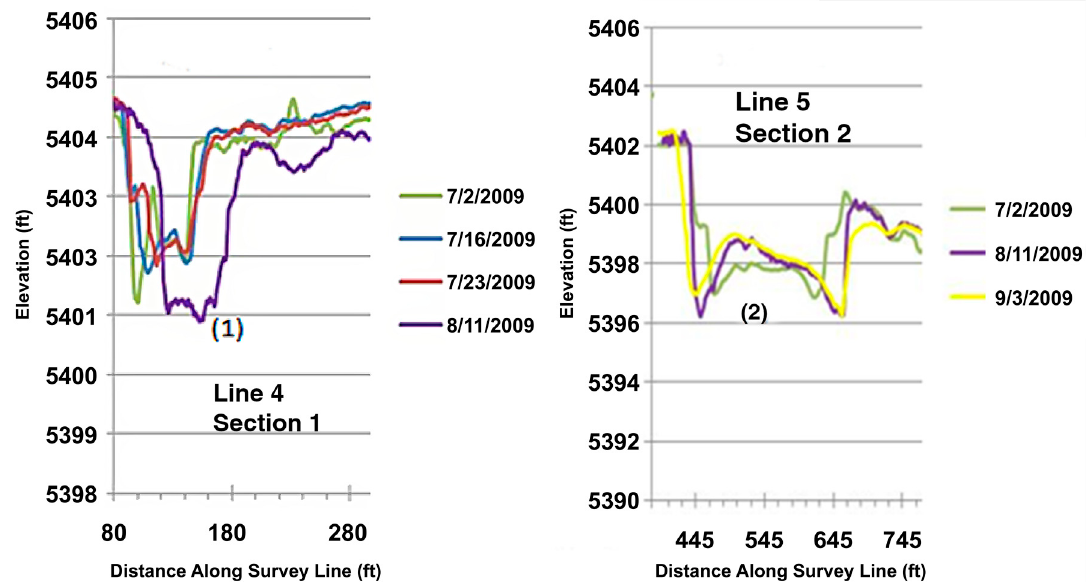
Figure 9. Detailed sections from Line 4 and Line 5 showing re-cutting and channel movement (Line 4) and both re-cutting with little channel movement (Line 5).